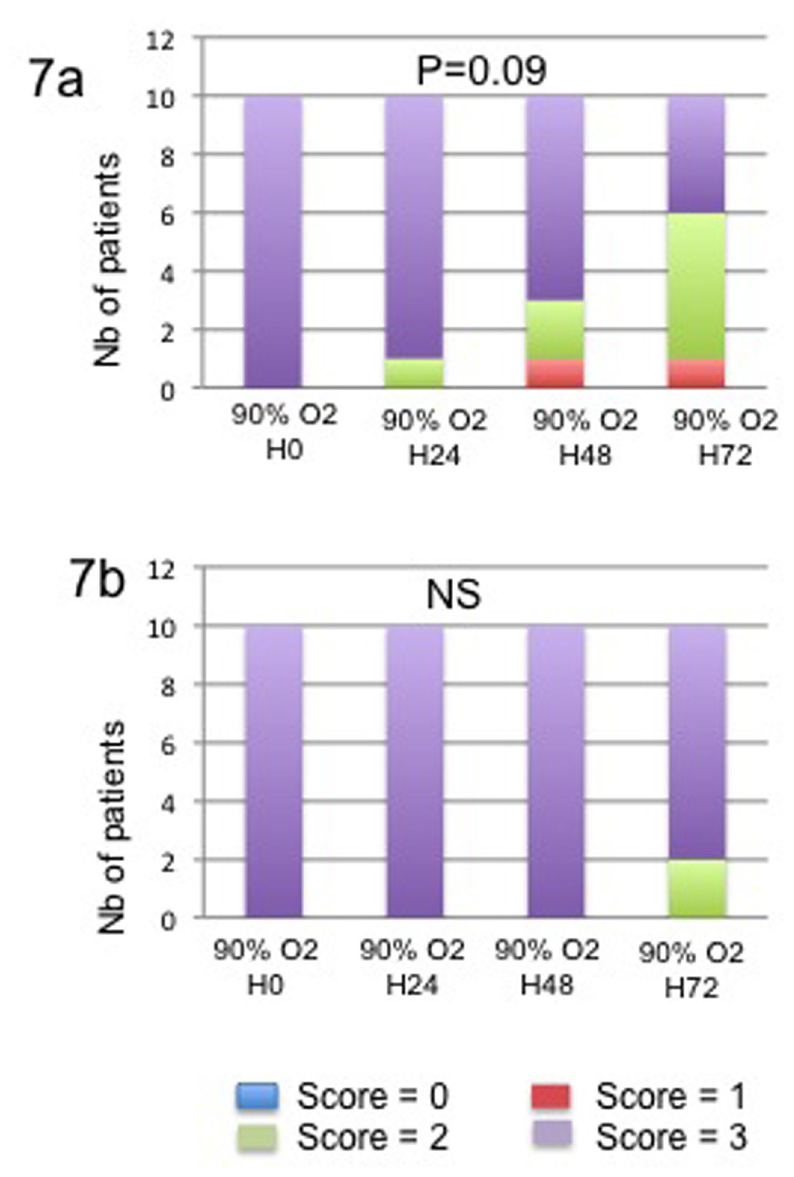
Figure 7. Expression of trypsin (7a) in acinar cells and CK7 in ductal cells (7b) under hyperoxic conditions of culture. The intensity of staining was evaluated as negative scored as 0, weak scored as 1, moderate scored at 2 and strong scored as 3. Results are expressed as the number of cases for each category of the score. doi: